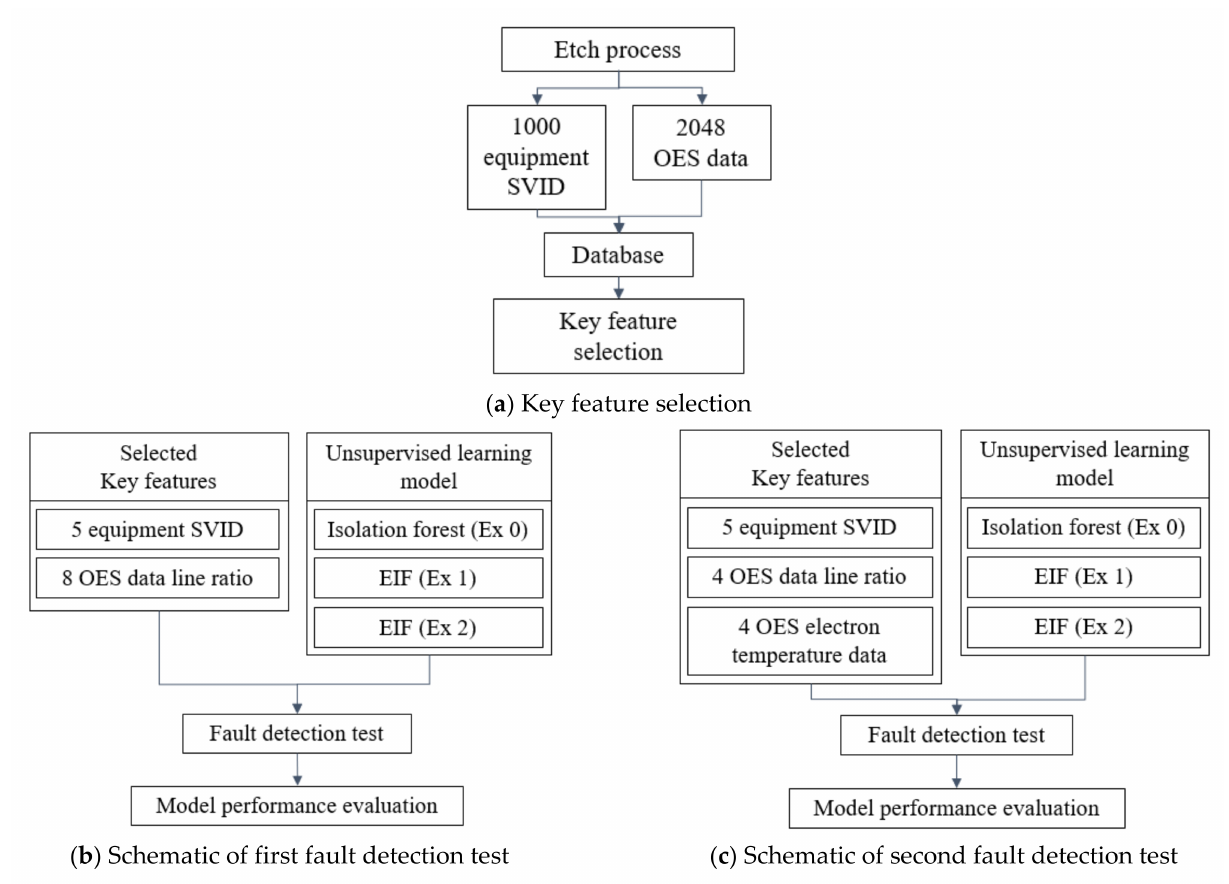
Figure 5. Schematic of flow in this study. The violin plot was used for key feature selection, and the accuracy of each model was compared using the precision, recall, and F1 scores. In addition, to evaluate